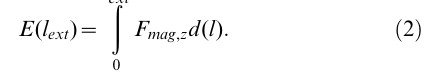
accurate determination of the mechanical parameters (Fig. S9) (parameters extracted